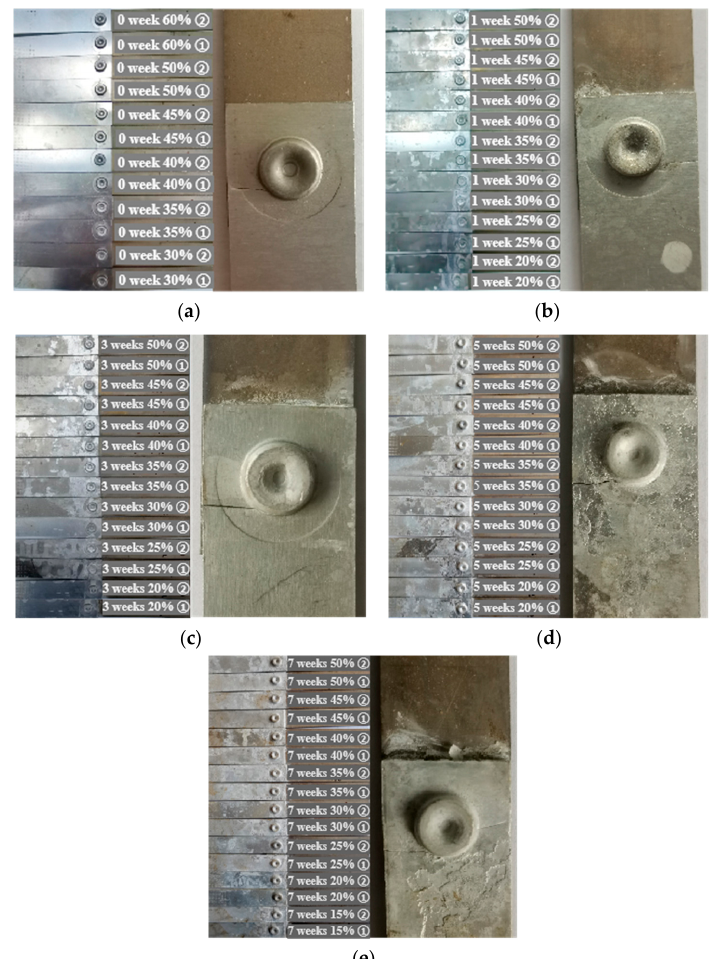
Figure 10. Fatigue failures of the SPR joints at different corrosion durations: ( a ) 0 week; ( b ) 1 week; ( c ) 3 weeks; ( d ) 5 weeks; ( e ) 7 weeks.